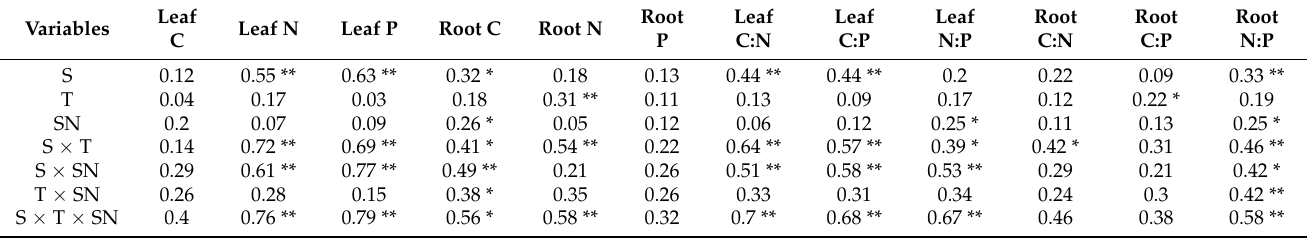
Table 5. Effects of species (S), topography (T), and soil nutrient (SN) on C, N, P stoichiometry traits in karst shrubs (R 2 contents of the generalized linear